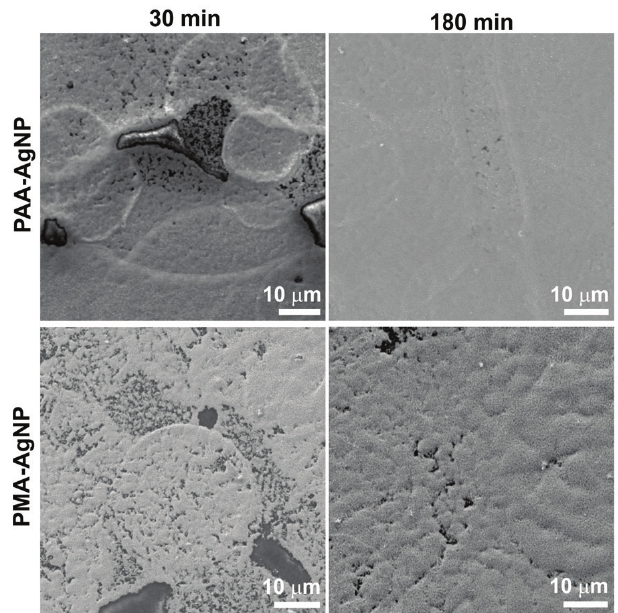
Fig. 5 – SEM images of printed surface of PAA-AgNP and PMA-AgNP ink after sintering at 120 °C for different sintering times (30 and 180 min)